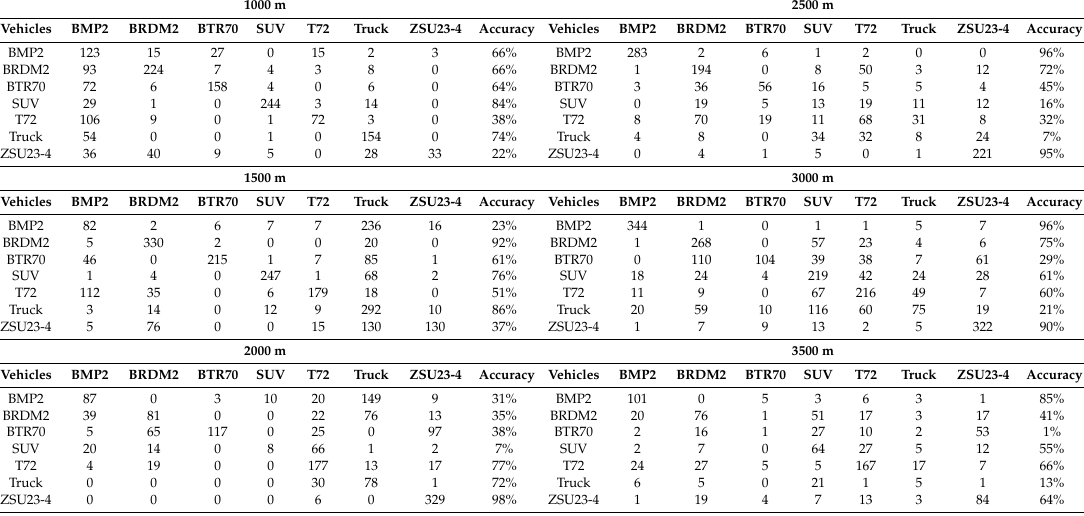
Table 6. Classification results for PCE Full (MWIR daytime) case. Left shows the confusion matrix and the last column shows the classification accuracy.